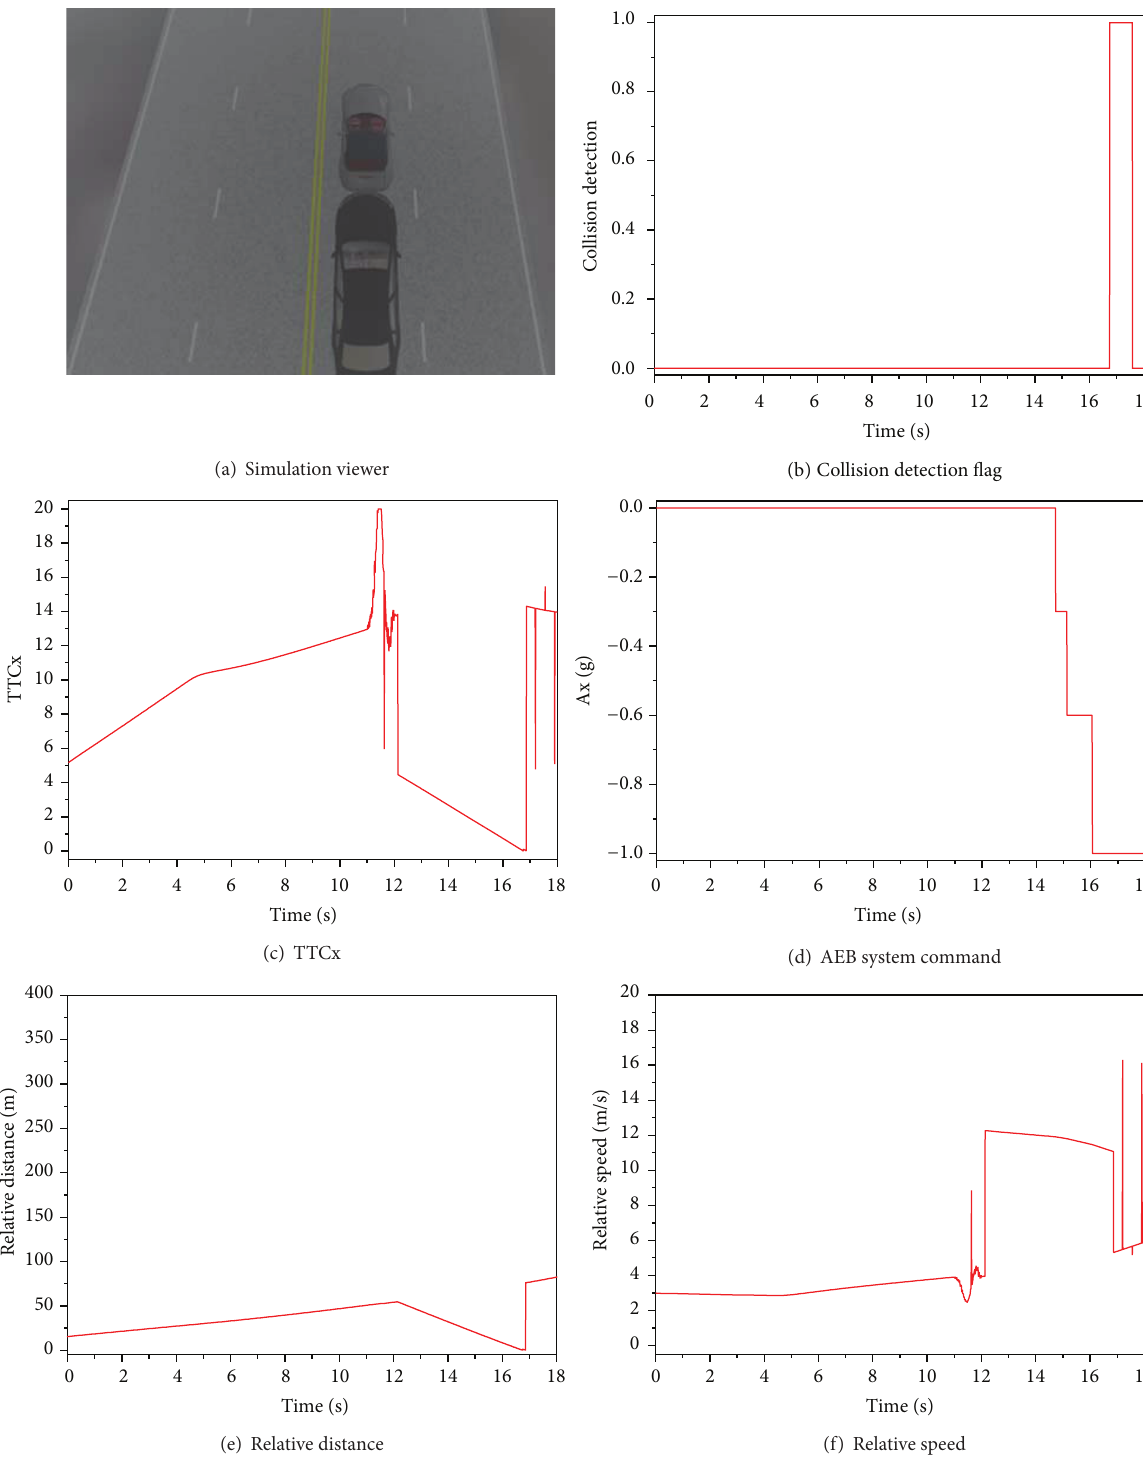
Figure 10: Vehicle-mounted-sensor-based AEB